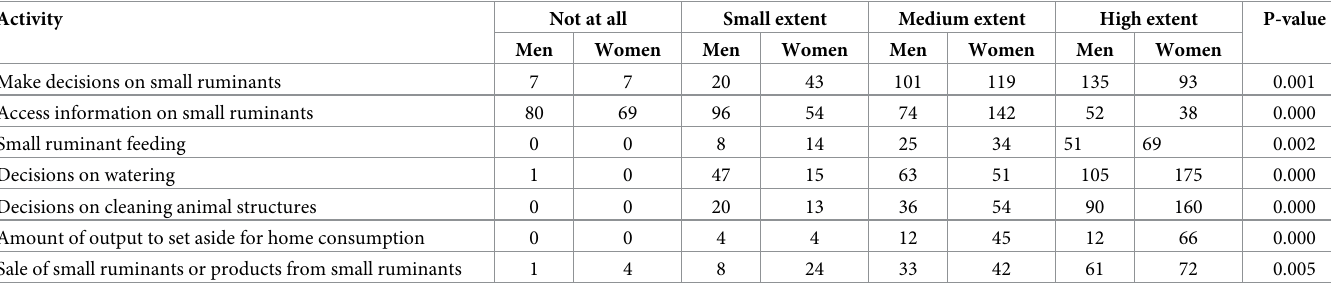
Table 9. Extent of participation in decision making on small ruminants’ production activities by men and women if they wanted. Activity